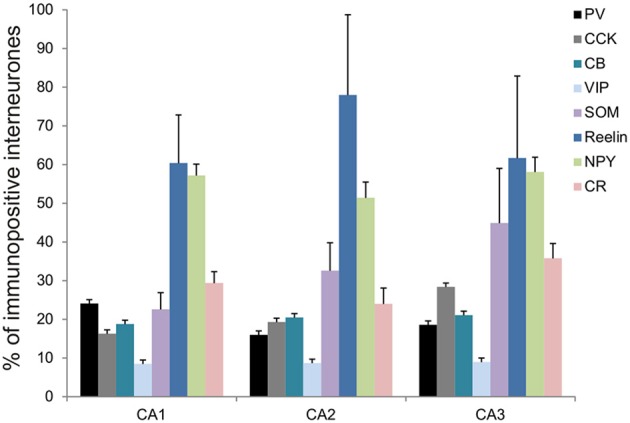
Molecular characterization of interneurons in the CA2 region of the hippocampus. Percentage of inhibitory cells that express parvalbumin (PV-black), cholecystokinin (CCK-gray), calbindin (CB-turquoise), Vasoactive Intestinal Peptide (VIP-light blue), somatostatin (SOM-purple), Reelin (dark blue), Neuropeptide Y (NPY-green), and calretinin (CR-pink) in each of the CA regions, CA1, CA2, and CA3. Total numbers of inhibitory neurons were obtained from the same sections labeled with anti-GAD67 antibodies.